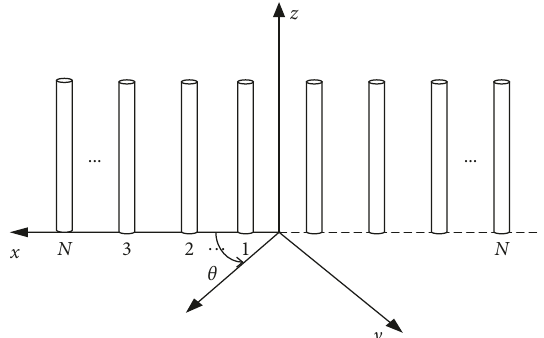
Figure 2: Geometric position distribution of 2 N -element linear